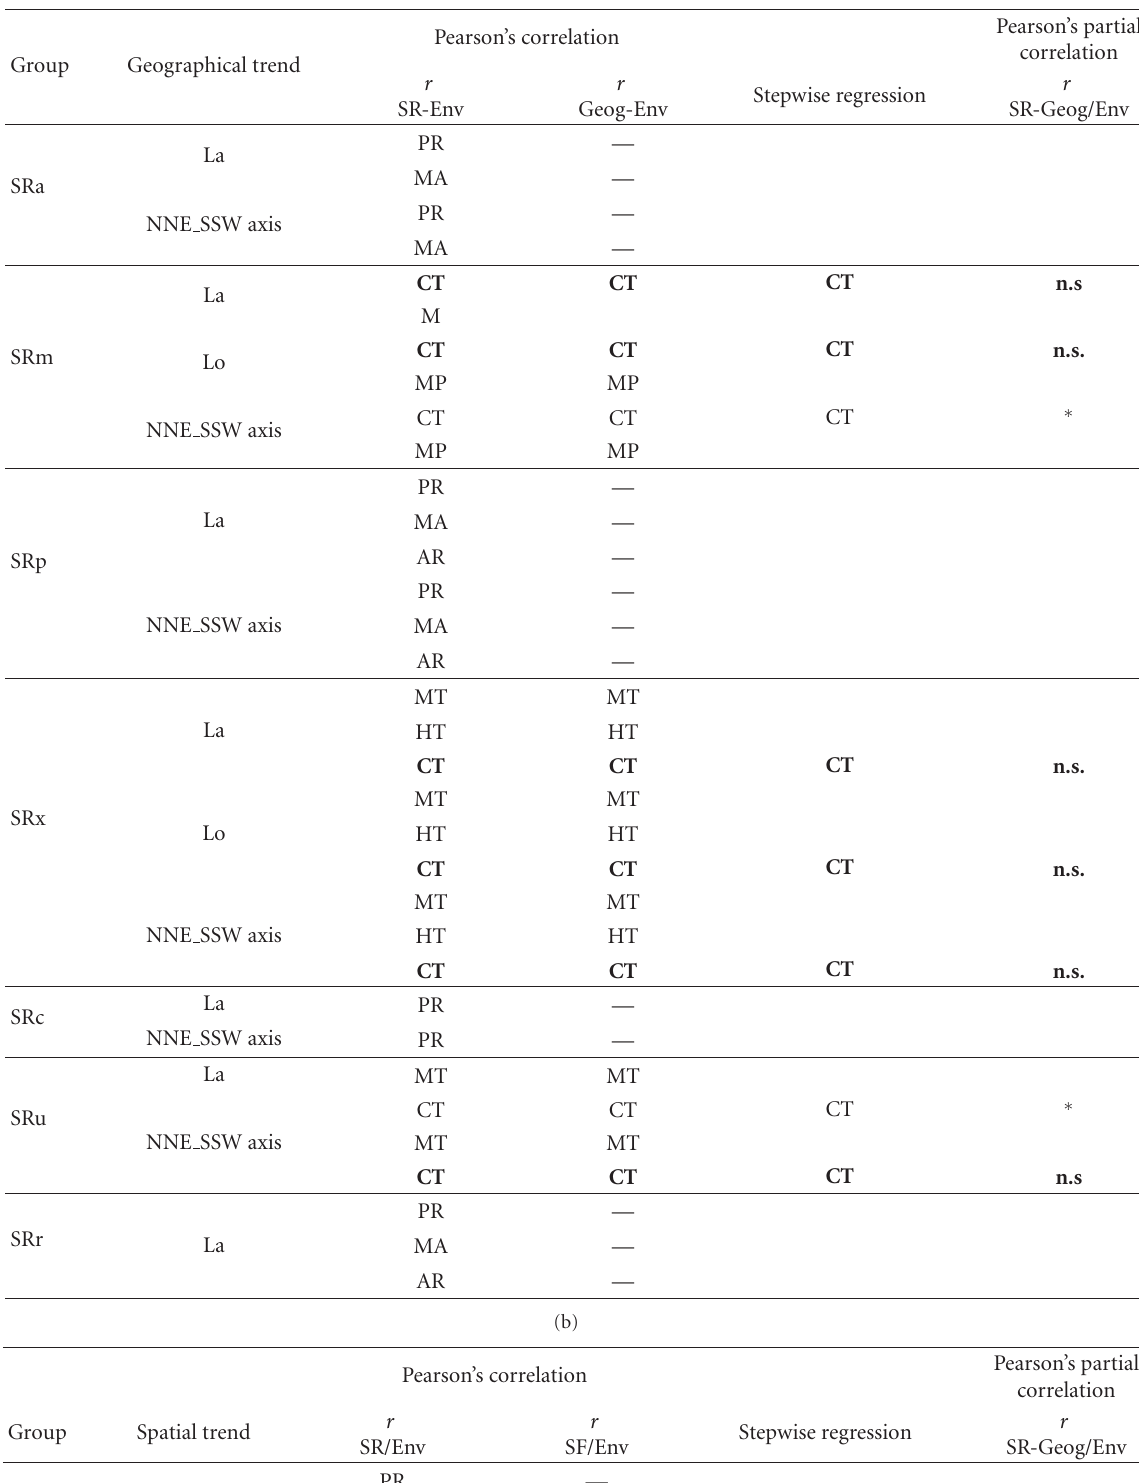
Table 5: Summary of the results for the geographical and spatial trends of each mammal group. Geographical trends (a) rSR-Env: environmental variables significantly correlated with SR, rGeo-Env: environmental variables significantly correlated with geographical variables. (b) rSF/Env: environmental variables significantly correlated with spatial filters. In bold environmental variables that explain the geographical or spatial trends. n.s: nonsignificant, ∗ P < 0 . 05. Variable codes as in Table 1 and Figure